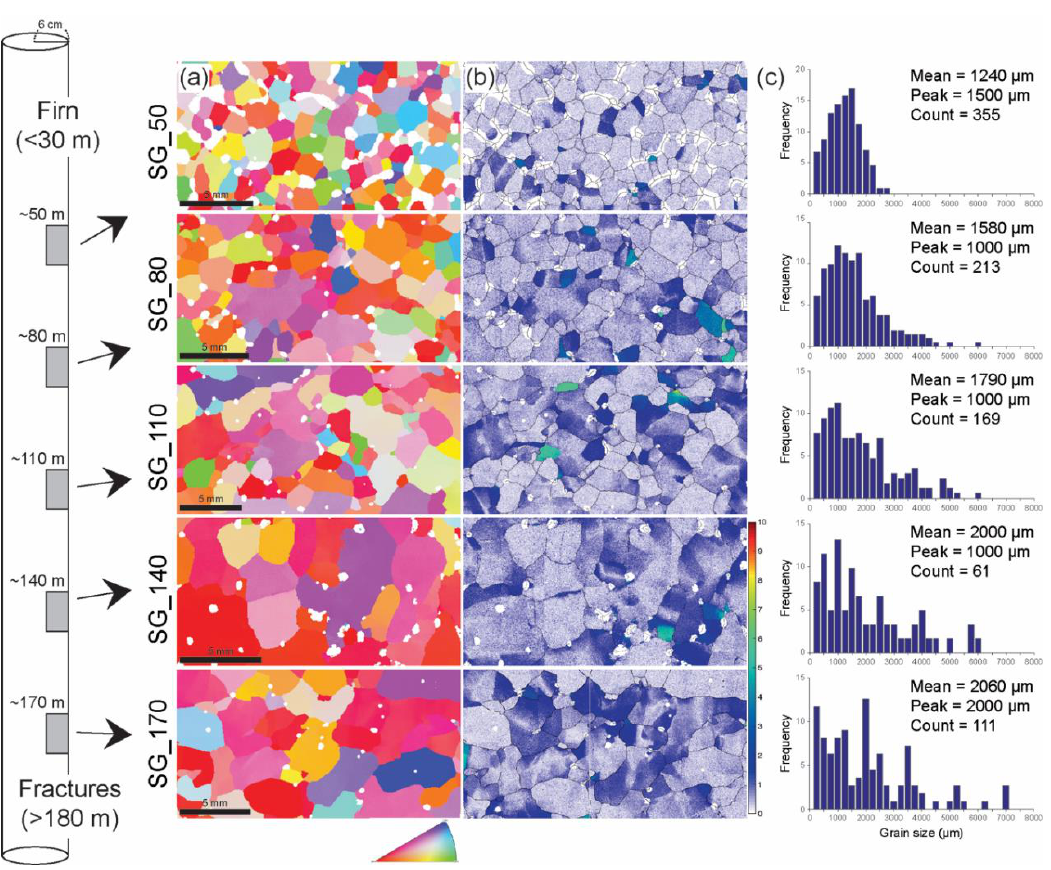
Figure 5. High-quality electron backscatter diffraction (EBSD) data showing ( a ) orientation (Euler angle), ( b ) mis2mean maps, and ( c ) grain sizes of the analyzed samples from the Styx Glacier. The locations of samples in the drilled core are shown to the left of ( a ). White areas in ( a ) and ( b ) present the existence of air bubbles. Color indices for ( a ) and ( b ) are located in the lower right of each. The maps in ( b ) show grain boundaries (>10°) as black lines. The MATLAB toolbox MTEX is employed for all figures.